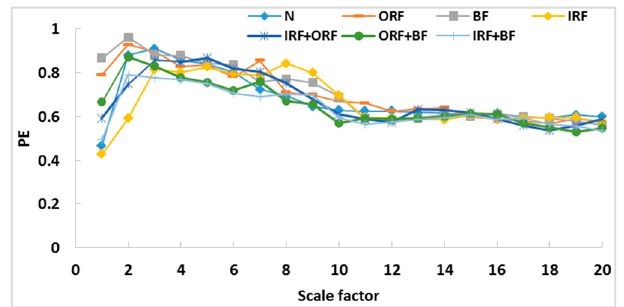
Figure 26. MPE of seven health conditions with different scale factors in Experiment 2.